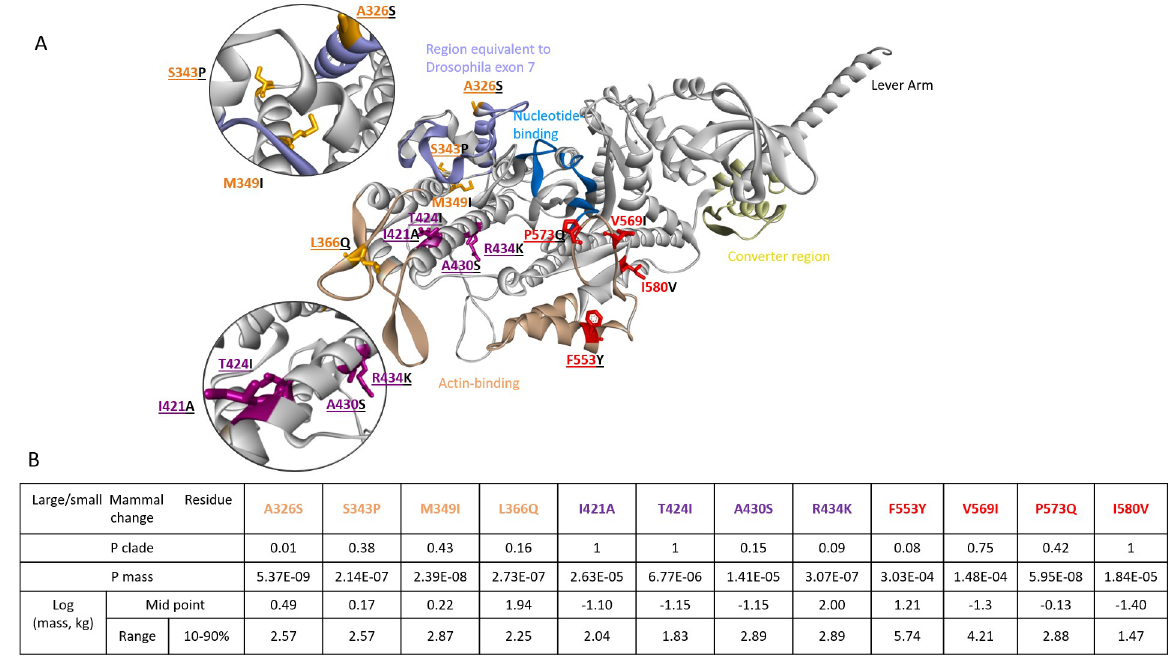
Fig 5. Location of residues switched in the chimera. Structure of human β -myosin (homology model based on Protein Databank ID 6FSA). The actin-binding site is highlighted in brown, exon 7 in blue, the nucleotide binding site in marine blue, and the converter region in yellow. The 3 groups of residues investigated are highlighted and labelled in orange (326, 343, 349, and 366), purple (421, 424, 430, and 434), and red (553, 569, 573, and 580) in each plot, and those that were switched are underlined. The structure shown represents one of the known conformations adopted by myosin during the turnover of ATP and is shown to illustrate the relative position of the residues of interest in relation to, e.g., actin- and ADP-binding sites. Since the residues highlighted are not directly coupled to ADP binding, it is likely that the stability of specific conformations and/or the transition (activation barrier) between conformations are affected by the sequence changes. For a review of the myosin motor domain structure, see [17,18],and for a broader discussion of activation barriers and conformational changes, see S1 Text and [19]. The table indicates the details about the 3 groups of variable residues, the adjusted probability (p adj ) of association with clade or mass, the log(mass) at the midpoint of the transition of the regression line between the 2 amino acids, and the range (10%–90%) over which the transition